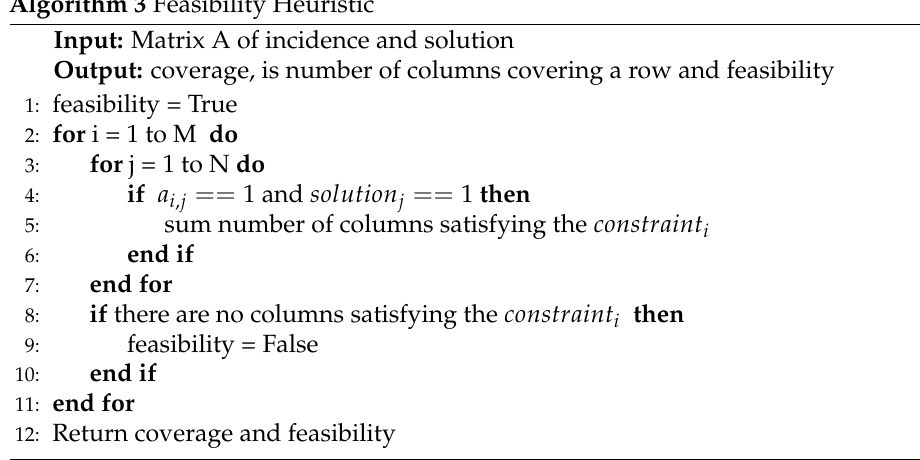
Algorithm 3 Feasibility